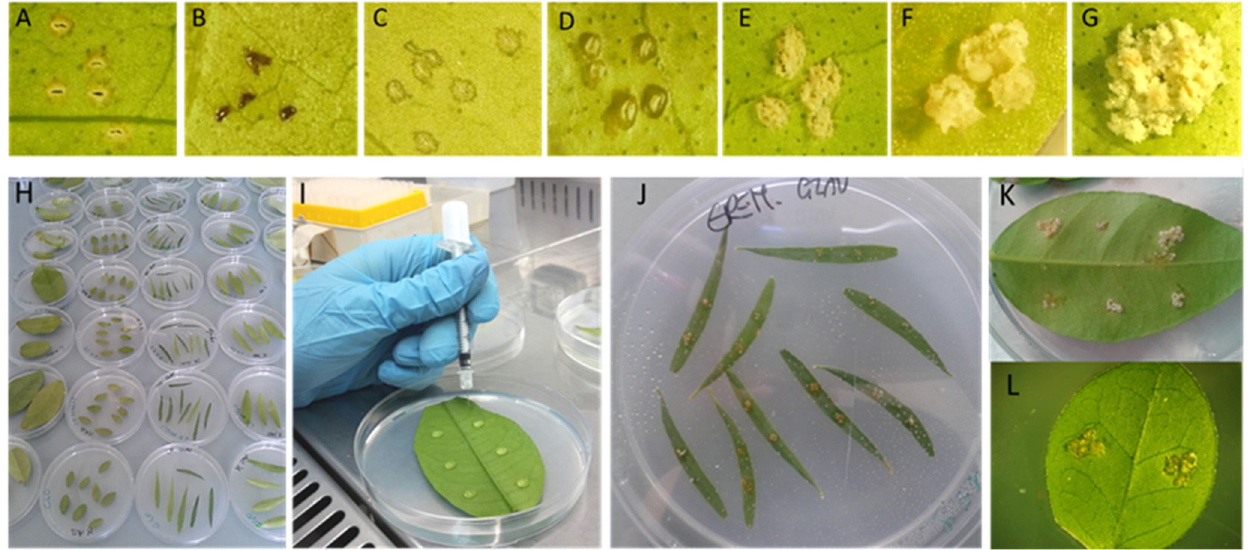
Figure 1. Host–bacterial strain interaction assessed by an in vitro test on detached leaves of Rutaceae inoculated with bacterial strains of Xanthomonas citri pv. citri and pv. aurantifolii . ( A – G ): exemplificative scale of symptomatic reactions measured as: “0”, wound repair ( A ) or necrosis ( B ); “ws”, water-soaked margin surrounding the wound sites ( C ); “+”, pustule or blister-like lesions ( D ); “++”, beginning of callus formation or crystalline callus at inoculation site ( E ); “+++”, abundant crystalline callus (5 sites) ( F ); “++++”, confluent crystalline callus in a single hyperplasia ( G ). ( H ) leaves of different Rutaceae placed on the surface of Petri dishes containing soft water agar (1%)